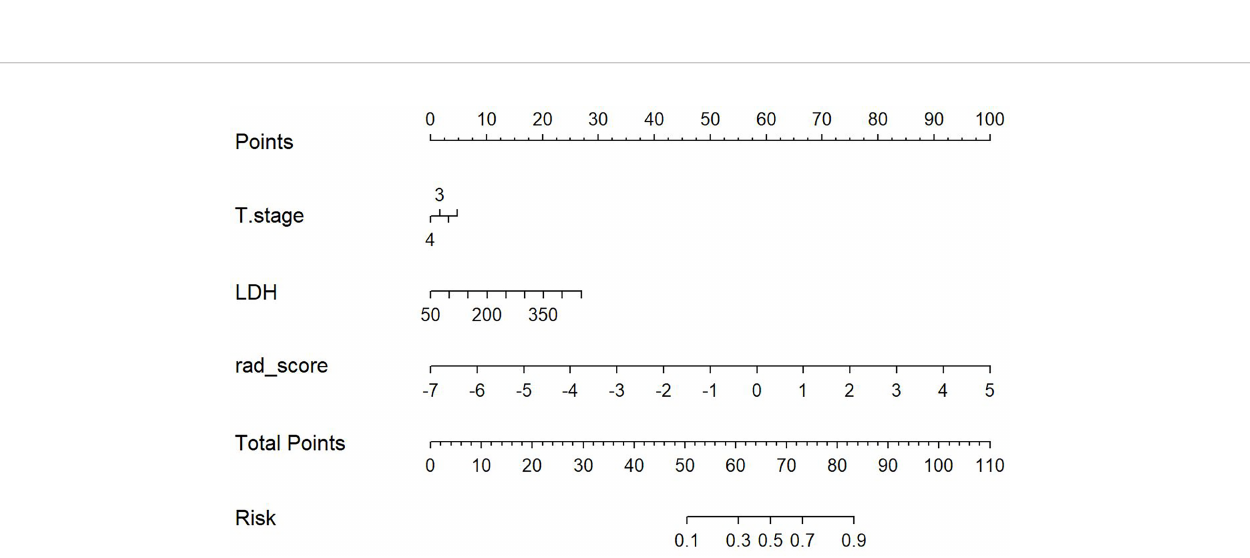
FIGURE 9 | Construction of the model nomogram based on the tumor (T) stage and lactate dehydrogenase (LDH) level in combination with the enhanced T1- weighted imaging (T1WI) sequence.